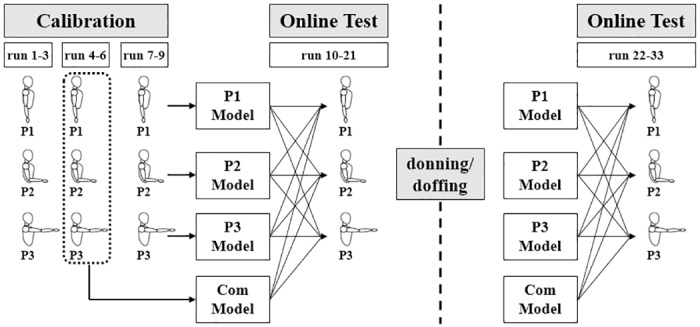
Experimental paradigm designed for investigating the impacts of arm position change and donning/doffing on the online performance of myoelectric control.Three calibration runs are sequentially performed on each arm position (P1→ P2→ P3) and this procedure is repeated three times (run 1–9). Then, three position-specific and one combinatory regression models are separately constructed by using the calibration data sets measured on each arm position and by combining one run of each arm position (run 4–6) (P1 Model, P2 Model, P3 Model, and ‘Com’ Model). Note that the same amounts of calibration data are used for modeling the four linear regression estimators to avoid biased results (3 calibration data for each model). In the online evaluation run, all possible combinations of the four regression models and three arm positions are tested using the target acquisition task (run 10–21), where the regression models and arm positions are randomly paired and presented to each subject. While the information of the current arm position is presented to the subject in the top right of the monitor screen (see Fig 2(a)), the given regression model is blinded to not only the subject but also the experimental instructor so as to prevent possibly biased results (double-blind study). After the first 12 online test runs (run 10–21), the electrode integrated hose is taken off and again put on around the original position without specific criterion to simulate a natural donning/doffing situation, and then the same 12 test runs are performed with another randomized order of the regression models and arm positions (run 22–33). The original and shifted locations of the electrodes are manually measured and recorded to see the effect of shift distance on online performance, for which the electrode locations are marked with a water-based sign pen and the distance between the original and shifted electrode locations is estimated with a tapeline. Note that electrode positions are clearly imprinted on target muscles because the electrode integrated hose naturally presses the muscles during the experiment (no subjects claimed any pain).